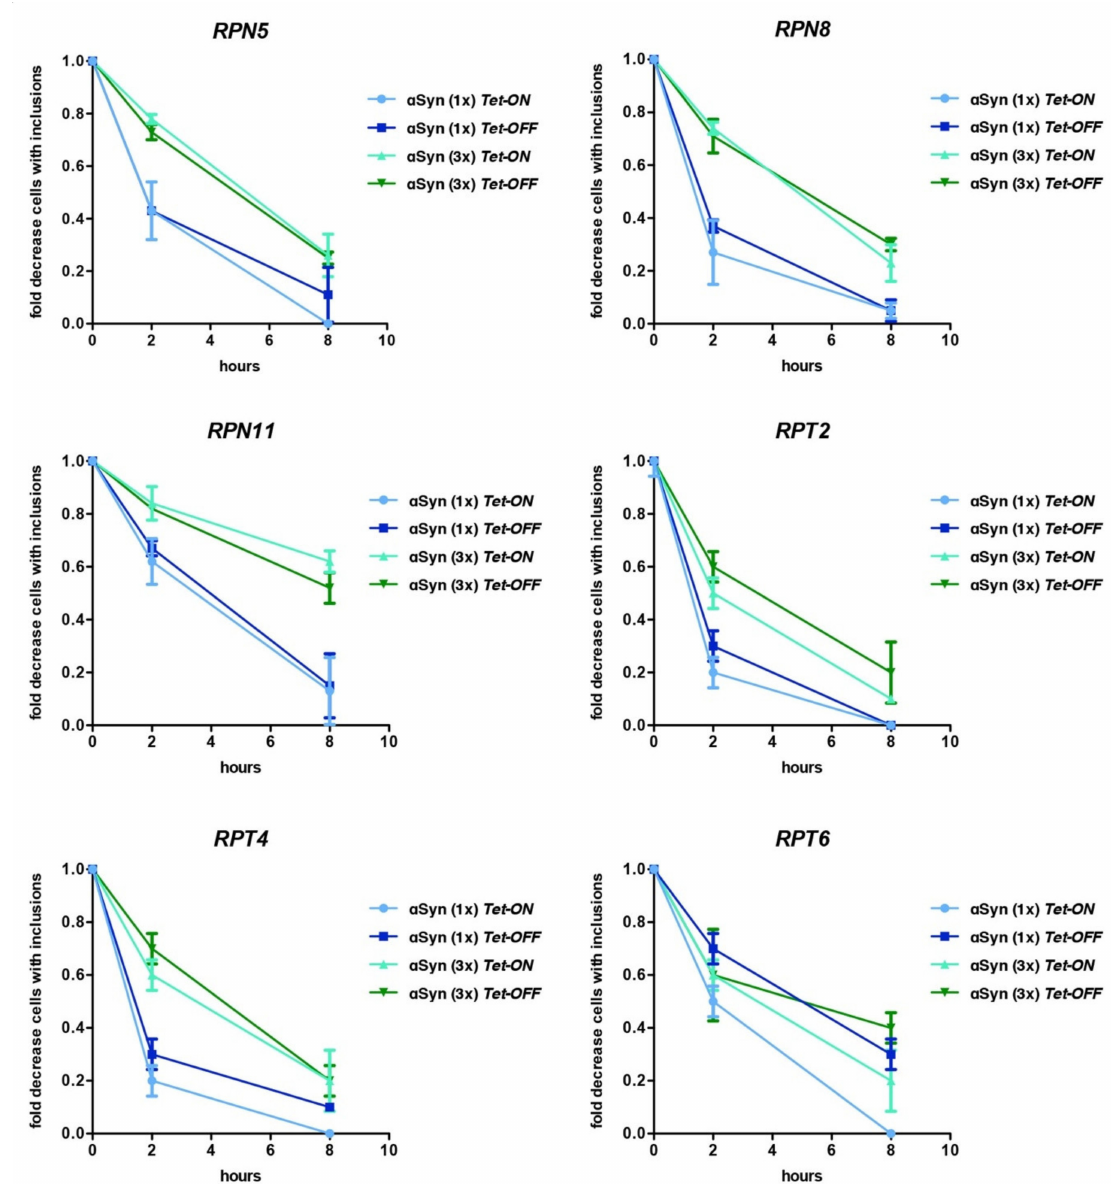
Figure 7. Downregulation of the proteasome gene expression does not significantly affect α Syn aggregate clearance. α Syn aggregate clearance after GAL1 -promoter shut-off of cells expressing α Syn-GFP from one or three gene copies. Cells were grown overnight in galactose-containing medium for induction of protein expression and then shifted to a glucose medium that represses the GAL1 promoter. The cells with inclusions were counted at time points 0 h, 2 h and 8 h after GAL1 -promoter shut-off and normalized to time point zero. The Tet promoter was downregulated by addition of 10 µ g/mL doxycycline to the growth medium. Values represent the mean ± SEM of three independent